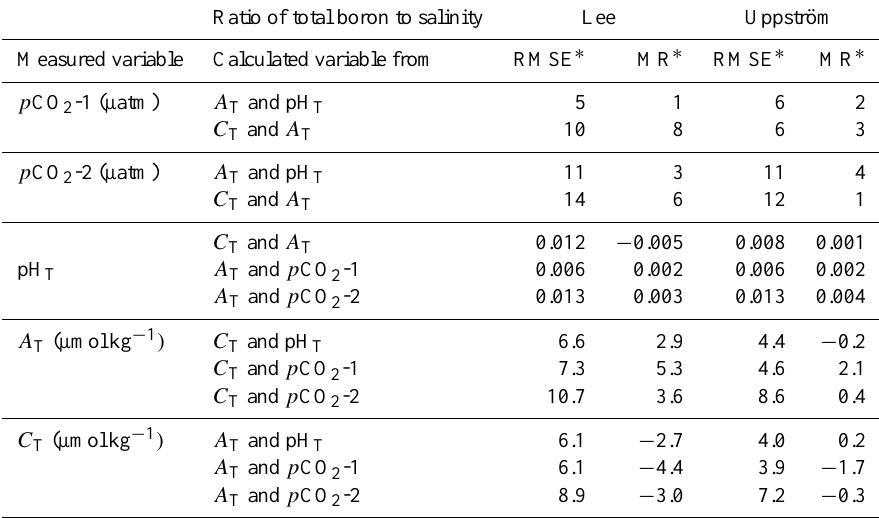
Table 2. Directly measured pH T , partial pressure of CO 2 ( p CO 2 -1), dissolved inorganic carbon ( C T ) and total alkalinity ( A T ) are compared to values calculated for the combinations of pairs involving A T using different ratios of total boron to salinity. RMSE is root mean square error and MR is mean of the residuals. The two different ratios of total boron to salinity are from Lee et al. (2010) and Uppström (1974). The carbonate constants are from Mehrbach et al. (1973), refitted by Dickson and Millero (1987).